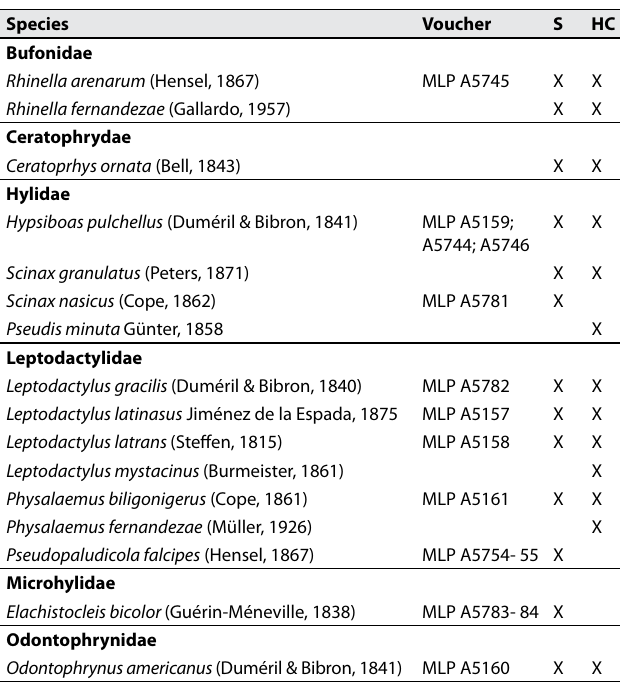
Table 1. Species account. S: species found in our surveys. HC: species from herpetological